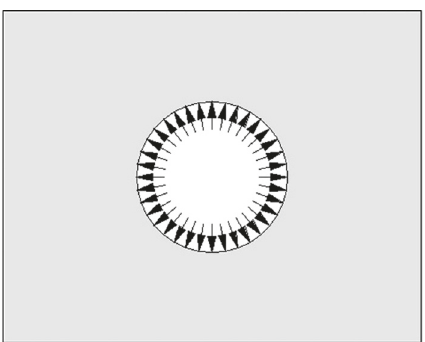
Figure 9: Pressure distributions caused by uniform corrosion, as applied in simulations